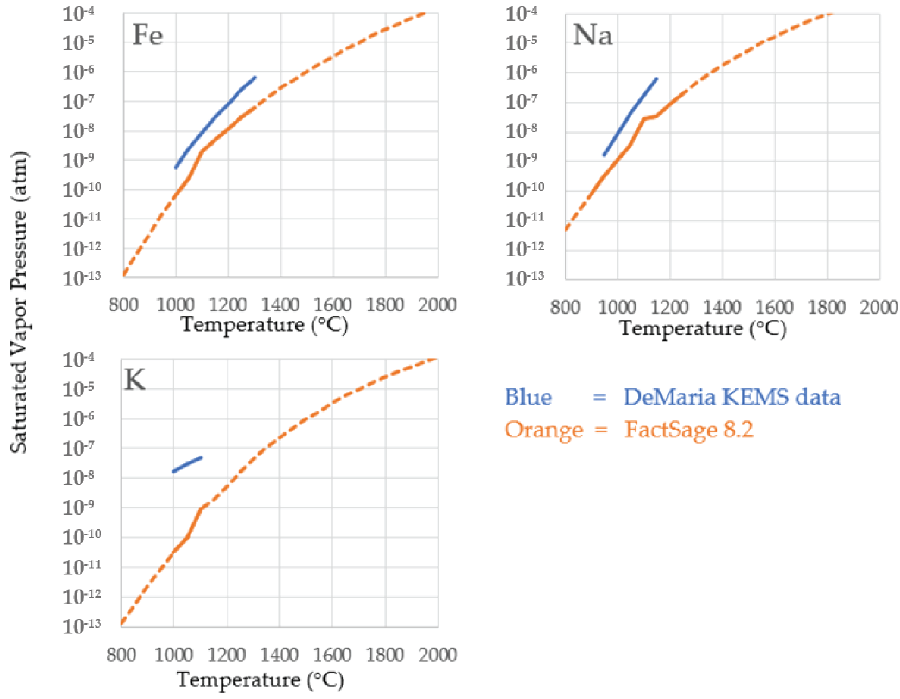
Figure 3. Comparison between measured saturated vapor pressure of species Fe, Na, and K from De Maria et al. [15] shown in blue, and the prediction by FactSage 8.2 software shown in orange, given the Apollo sample #12022 feed shown in Table 1.